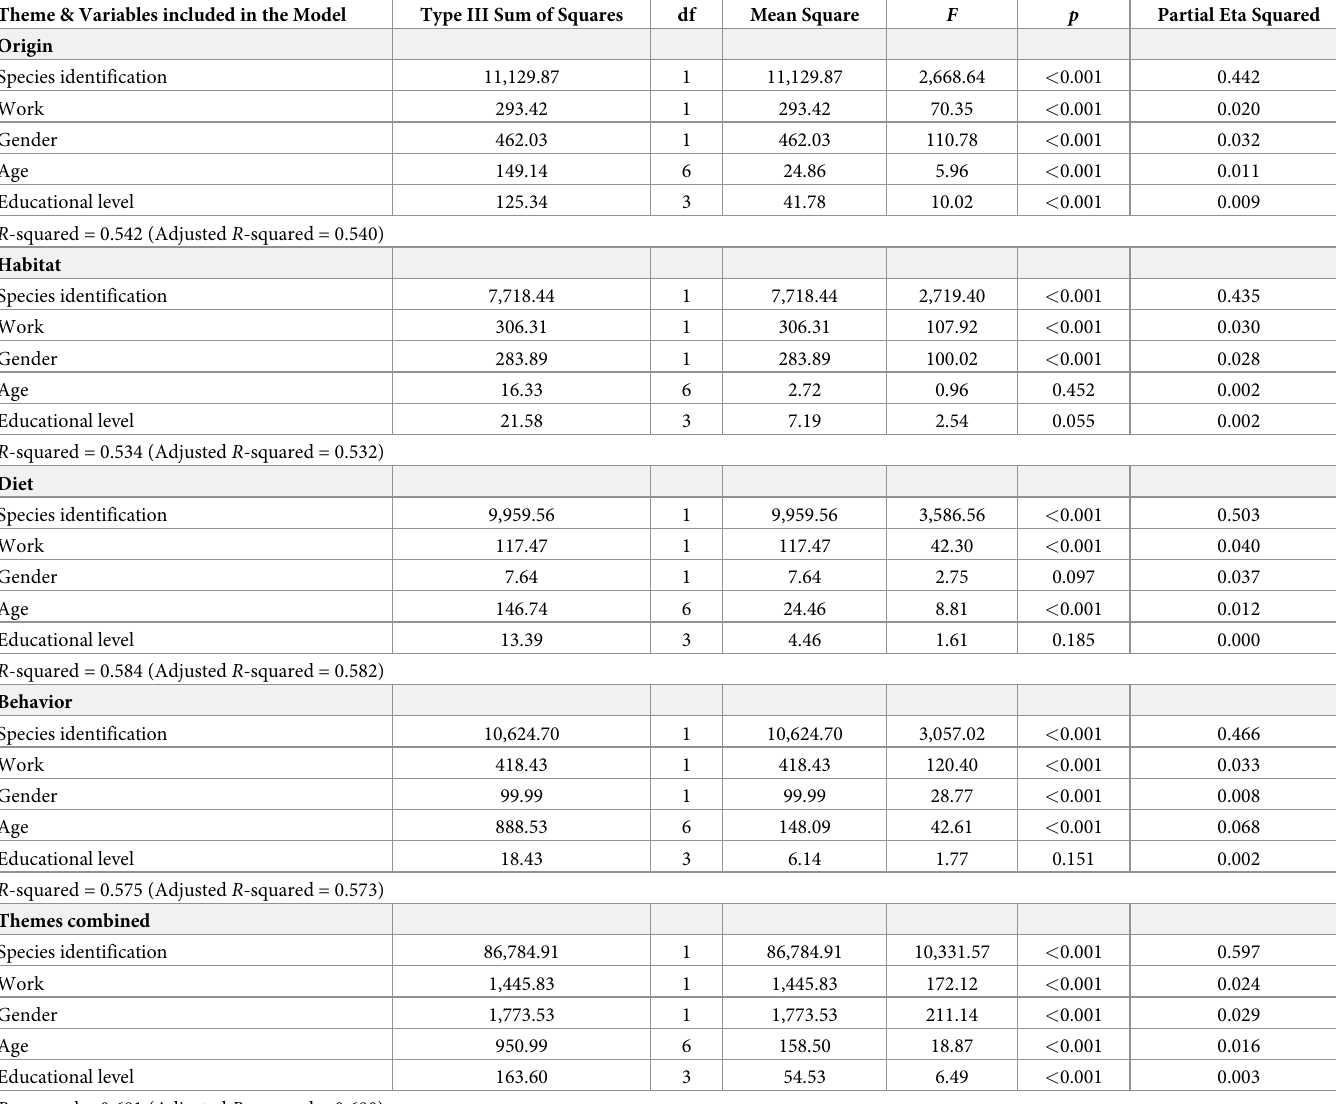
Table 3. Regression analyses of predictors of people’s in-depth knowledge about species (subdivided into four